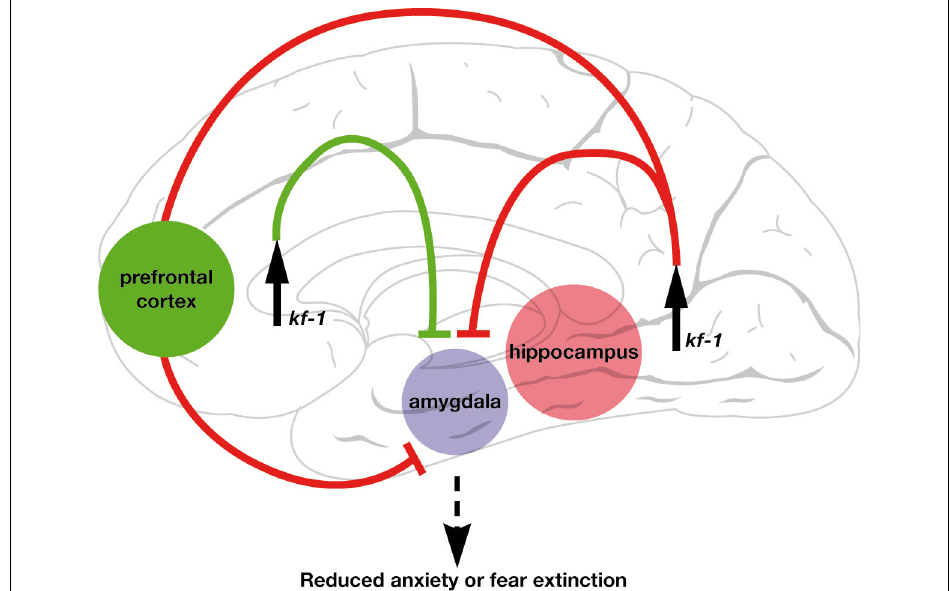
Figure 4 | A circuitry presentation of the anxiety suppressor model by the up-regulation of kf-1 expression. The circuitry model was constructed by considering the fear extinction neural model (Sotres-Bayon et al., 2006). The anxiolytic pathway after kf-1 up-regulation is incorporated into the